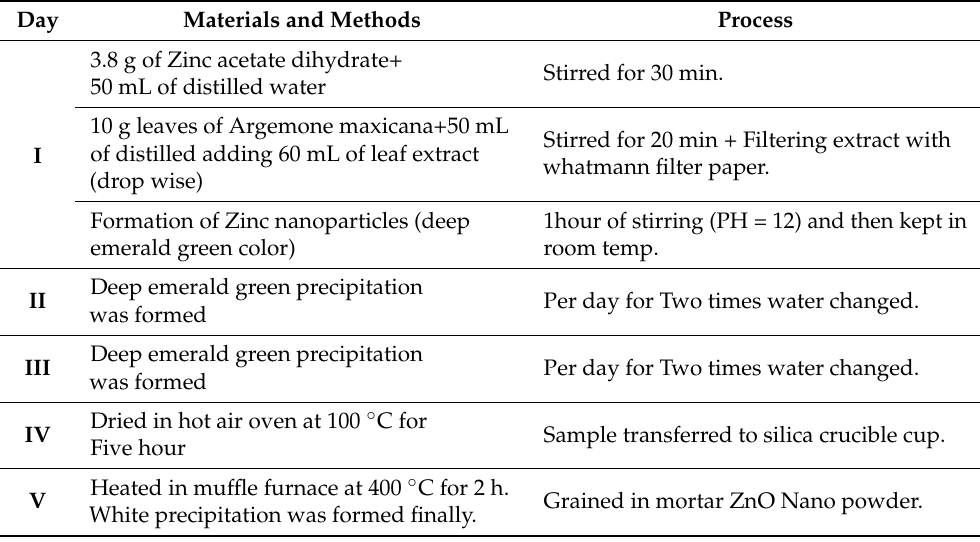
Table 8. Details of green biosynthesis experiment